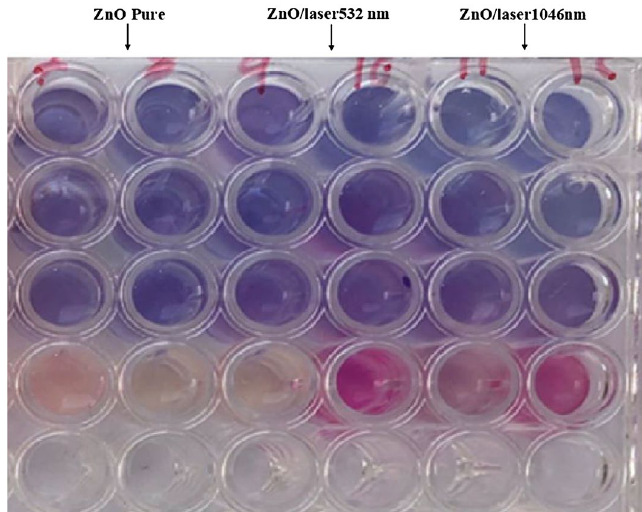
Figure 12. The results showed the effectiveness of ZnO-NPs against